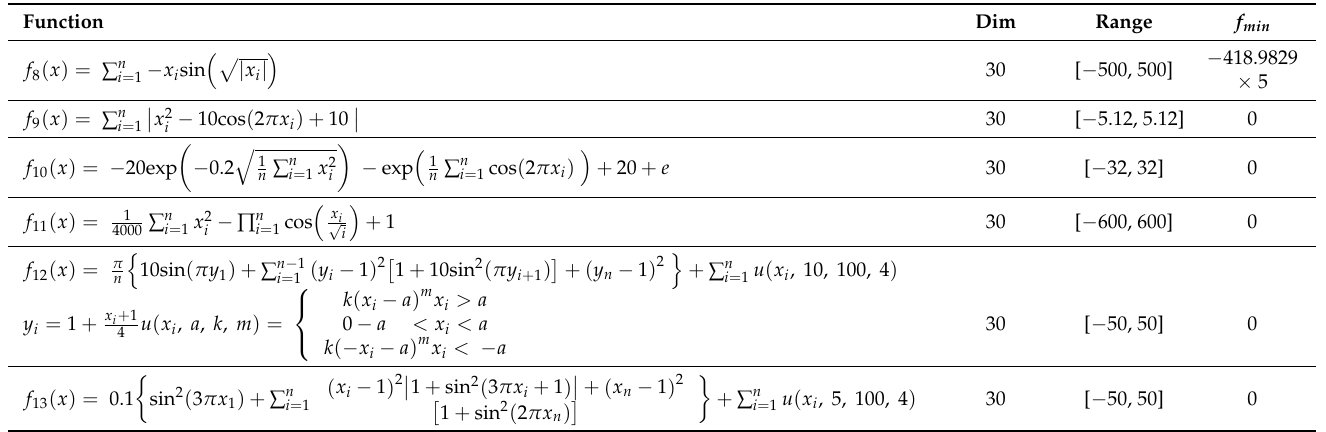
Table 4. Multimodal benchmark